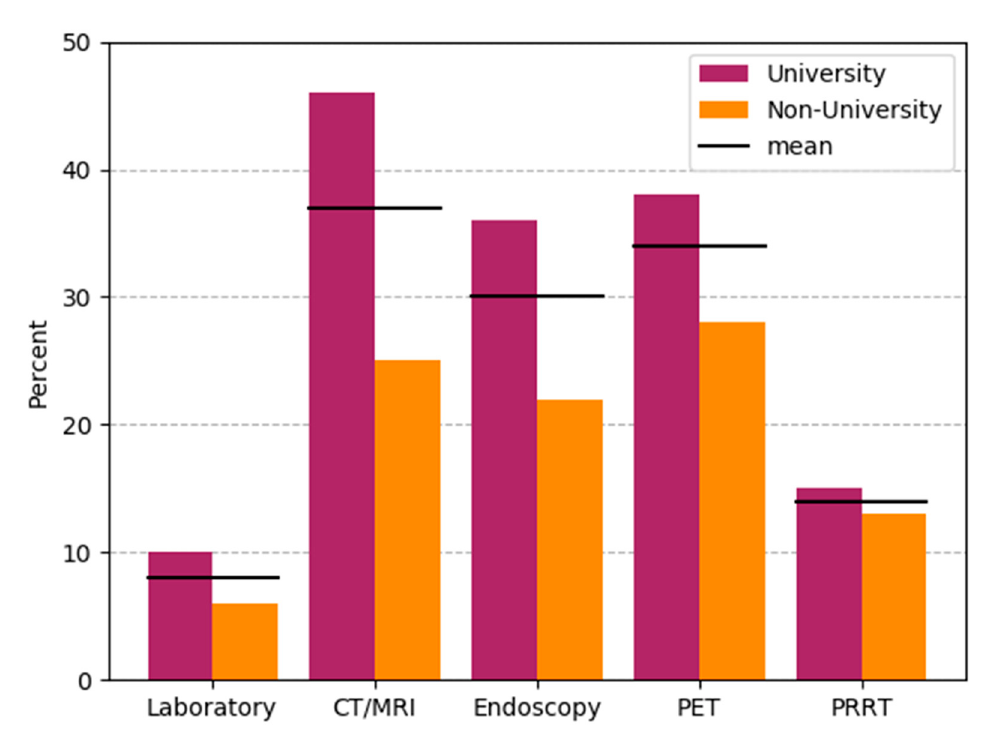
Figure 3. Delays in diagnostics and therapy of NET patients. Bars are drawn separately for university hospitals ( n = 39) and non-university-based care such as non-university hospitals and private practices ( n = 32). Black horizontal bars indicate results for combined responses ( n = 71). PRRT: Peptide Receptor-mediated Radionuclide Therapy.